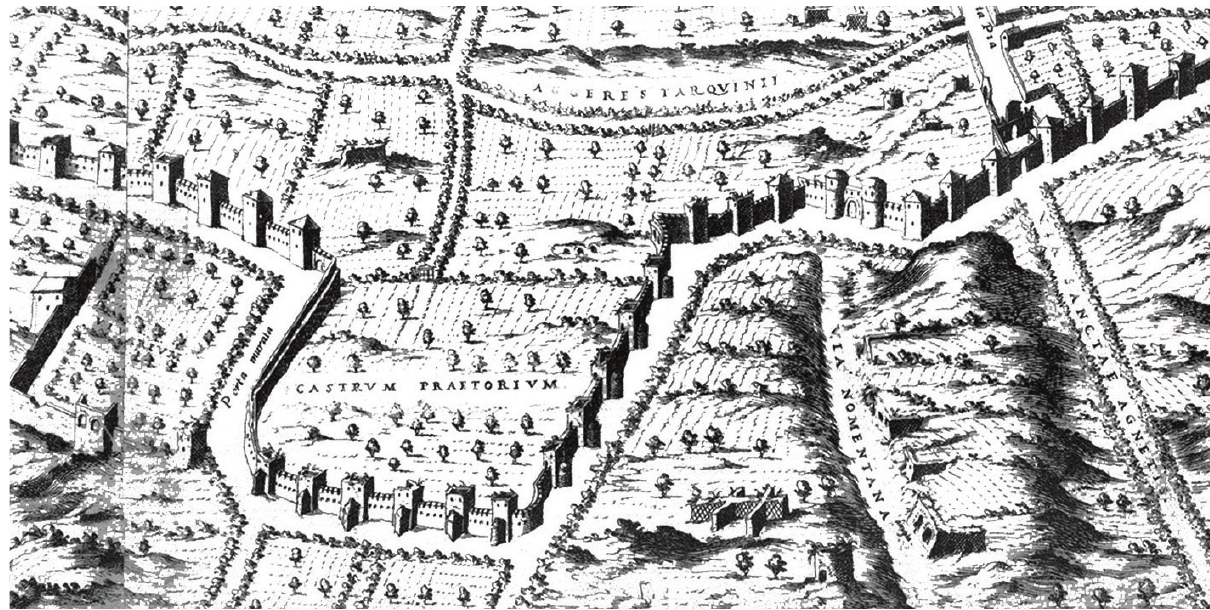
Figure 1. È. Du Perac, Nova Urbis Romae Descriptio, 1577. The Castro Pretorio area is abandoned, the wall was surrounded to Aurelian